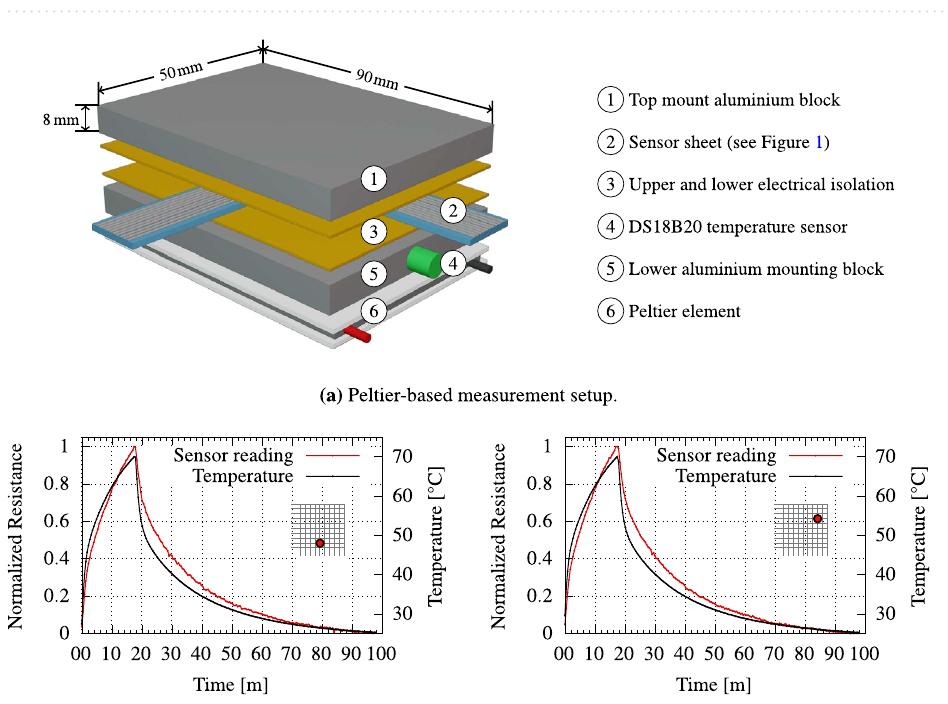
Figure 2. ( a ) Close-up image of the temperature sensor array with the bottom electrode (vertical lines), top electrode (horizontal lines) and the sandwiched PEDOT:PSS layer (transparent blue). The red arrow depicts the measurement direction conducted with a profilometer: ( b ) Surface structure of the sensor area. The PEDOT:PSS layer has a thickness of about 1 µ m. The underlying silver electrode has a thickness of 2–3 µ m. This thickness is found equal for top and bottom electrodes.